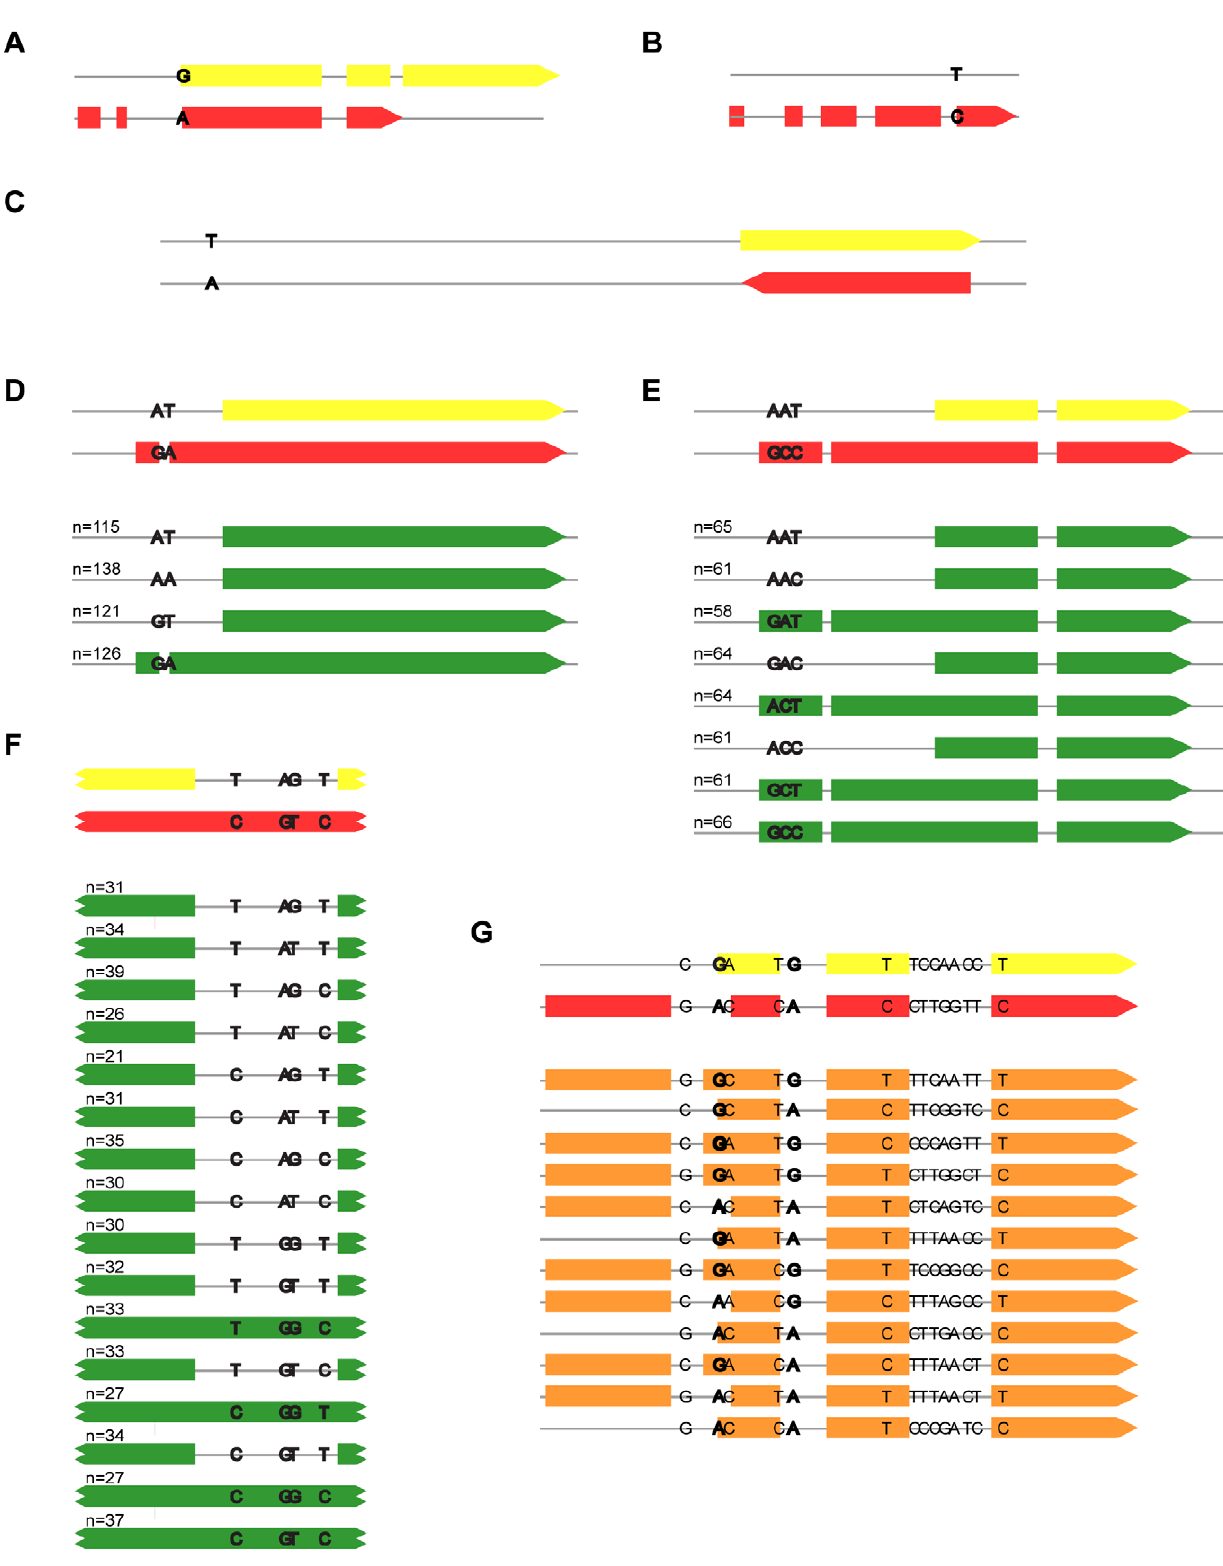
Figure 4. A variety of SNP genetic architectures affect exon model phenotypes. A–C) Diverse gene model phenotypes associated with a single SNP. A) A SNP is part of a start codon in vdB* and a splice acceptor in vdB on contig 21: 133200–133500 B). An entire five-exon gene is predicted in vdB but not vdB* on contig 24: 56700–57500. C) A rare example in which an intergenic SNP causes a gene to flip strands on contig 22: 2627100–2627839. D–F) Examples of events that are completely explained by multiple SNPs. All possible SNP combinations and associated phenotypes are shown in green. D) One SNP is part of a splice donor and a second SNP is part of a splice acceptor. Both must be present for